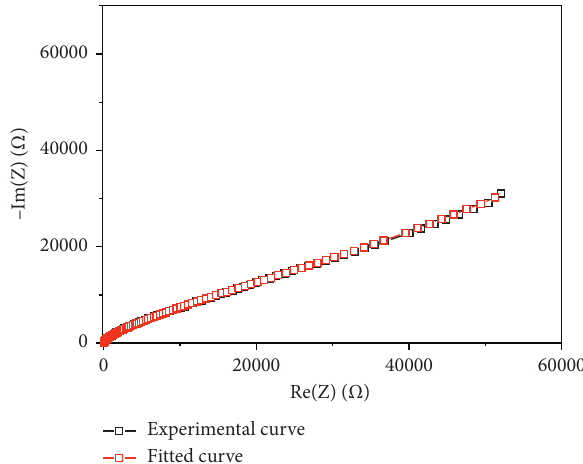
Figure 14: Nyquist representation and the best fit for the sample anodized at 30V in 5M phosphoric acid. The parameters from the best fits are given in Table 2. Table 2: Electrochemical parameters for the electrical equivalent circuit obtained in Na